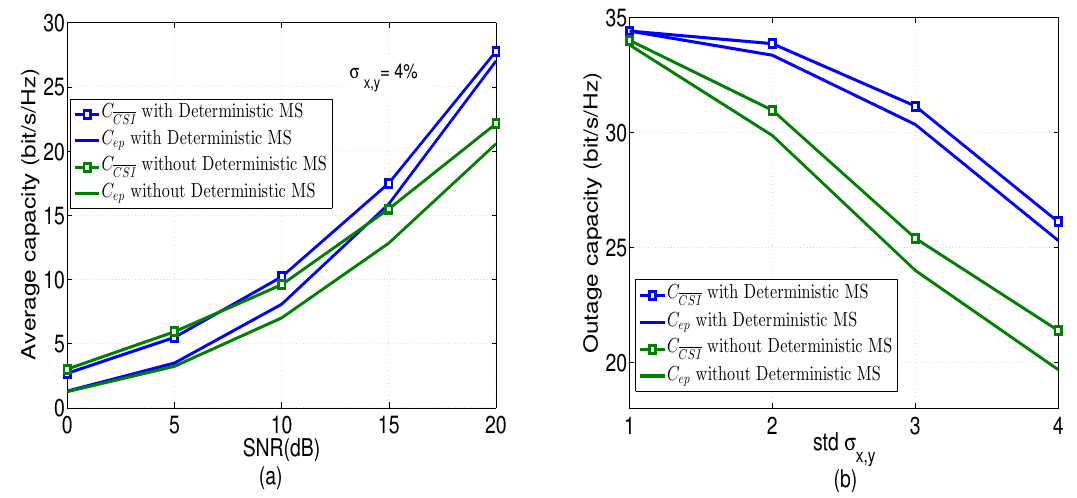
Figure 7. ( a ) Average capacities vs. SNR for the 10-mode fiber with a misalignment std σ x , y = 4% r c ; ( b ) Outage capacities vs. σ x , y for the 10-mode fiber for SNR = 20 dB and p out = 10 − 3